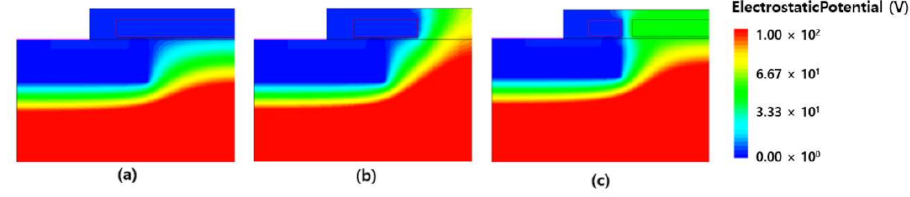
Figure 10. Electrostatic potential of ( a ) C-DMOSFET (conventional DMOSFET); ( b ) SG-DMOSFET (split-gate DMOSFET); and ( c ) FPS-DMOSFET (floating p+ polysilicon DMOSFET) in the off state (V DS = 3000 V, V GS = 0 V).